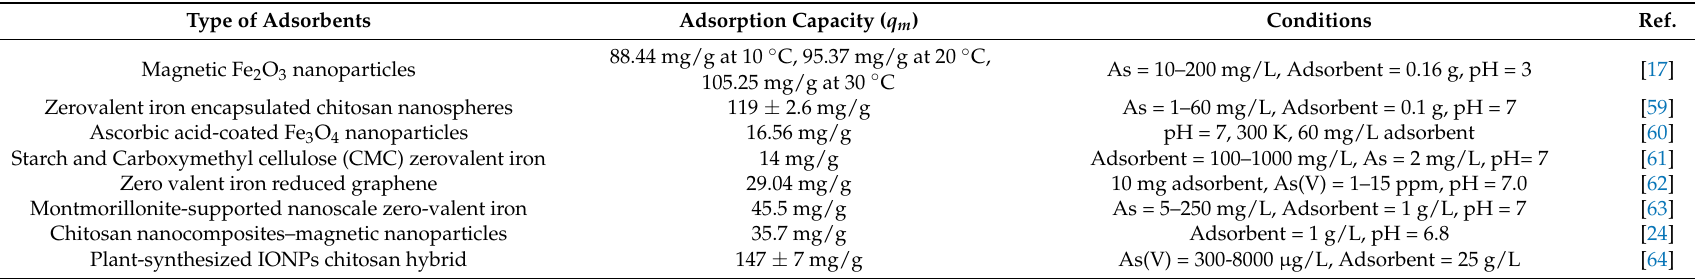
Table 3. Adsorption capacity of different adsorbents for As(V)